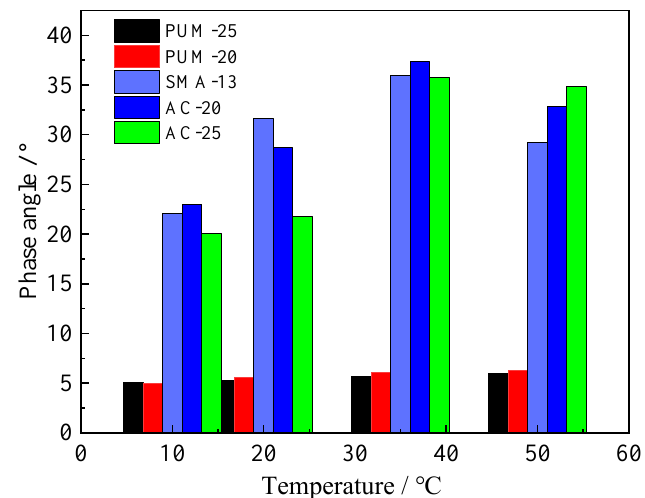
Figure 8. Phase angle at 10 Hz loading frequency.